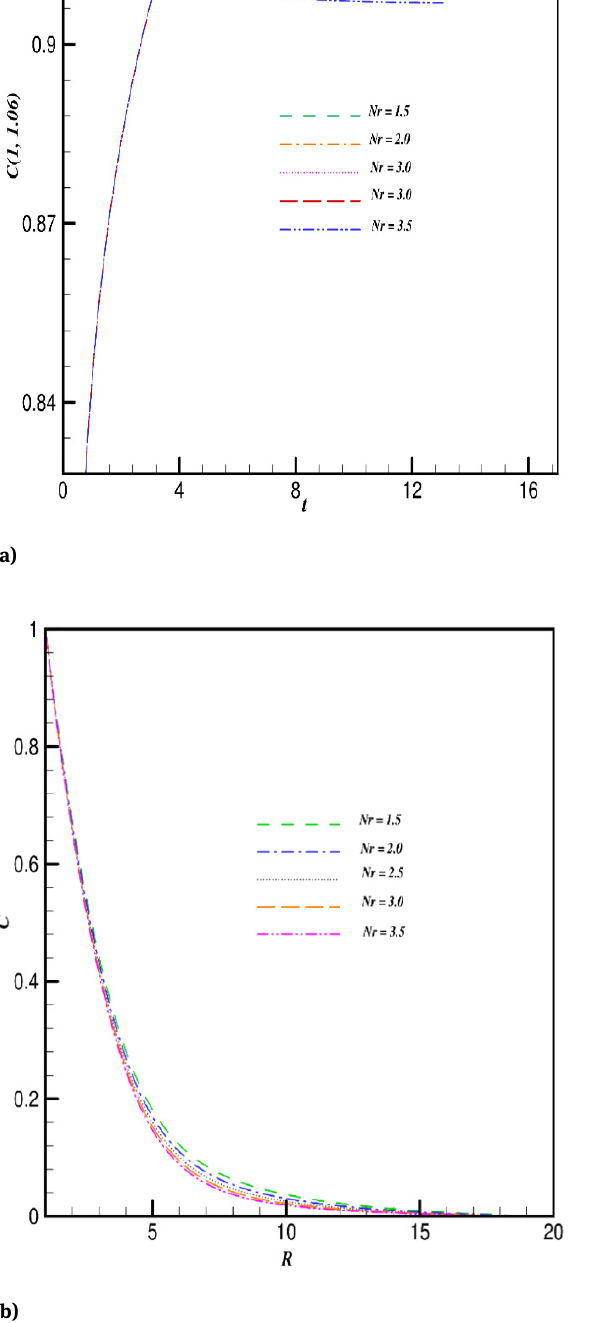
Figure 10: ( a ) Transient and ( b ) Steady state concentration profiles with fixed Sc = 0.6 , Pr = 0.7 , Bu = 1.0 , Kr = −0.2 , K 1 = 1.0 , M = 0.2 , Ec = 0.1 .